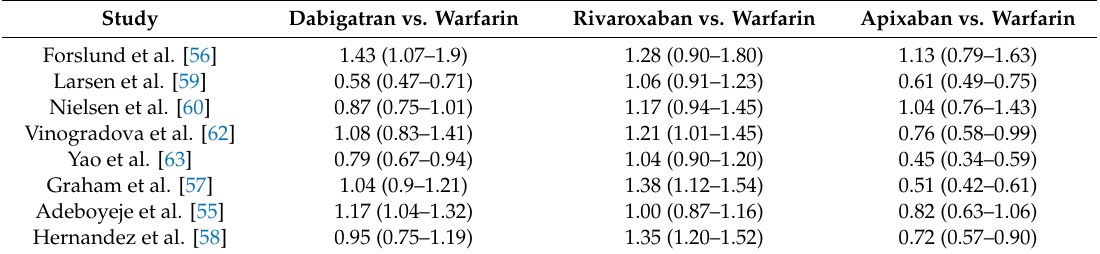
Table 5. Adjusted hazard ratios with 95% confidence intervals from comparisons of each NOAC versus warfarin for major gastrointestinal